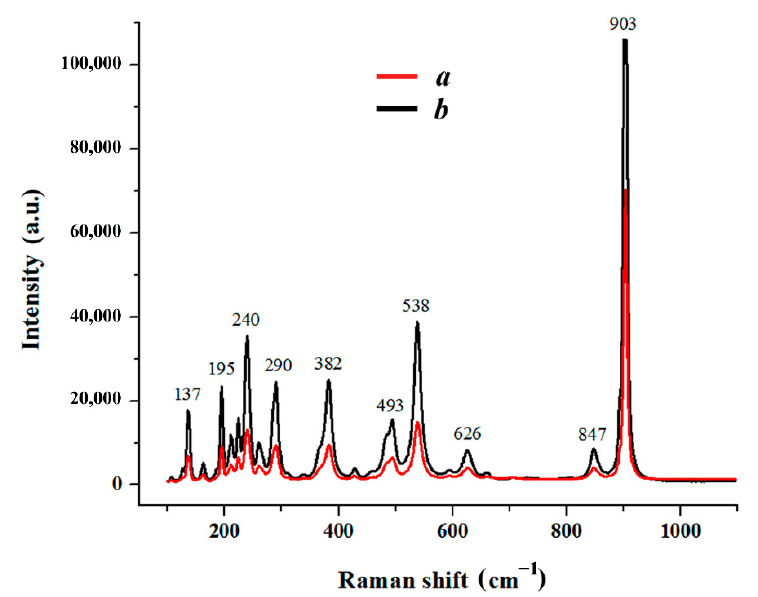
Figure 8. Raman spectra of the calcium metaniobate obtained after holding LiNbO 3 powders in the melts of (0.40CaCl 2 -0.60KCl) at 750 ° С ( a ) and (0.35CaCl 2 -0.65LiCl) at 700 ° С ( b ) under air atmosphere for 7 h.